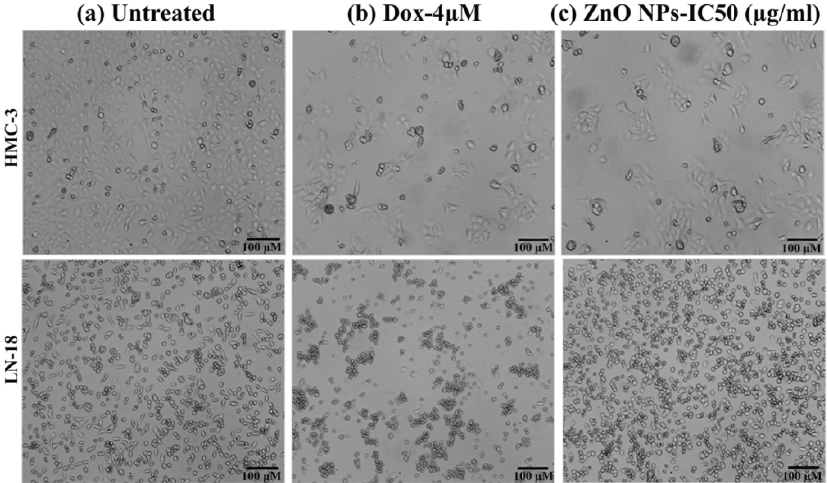
Figure 10. Morphology of HMC3 and LN18 cells treated with N-ZnO Ps compared: ( a ) untreated, ( b ) standard control cells, and ( c ) treated with 4 µM-doxorubicin. Scale bar 100 µm.